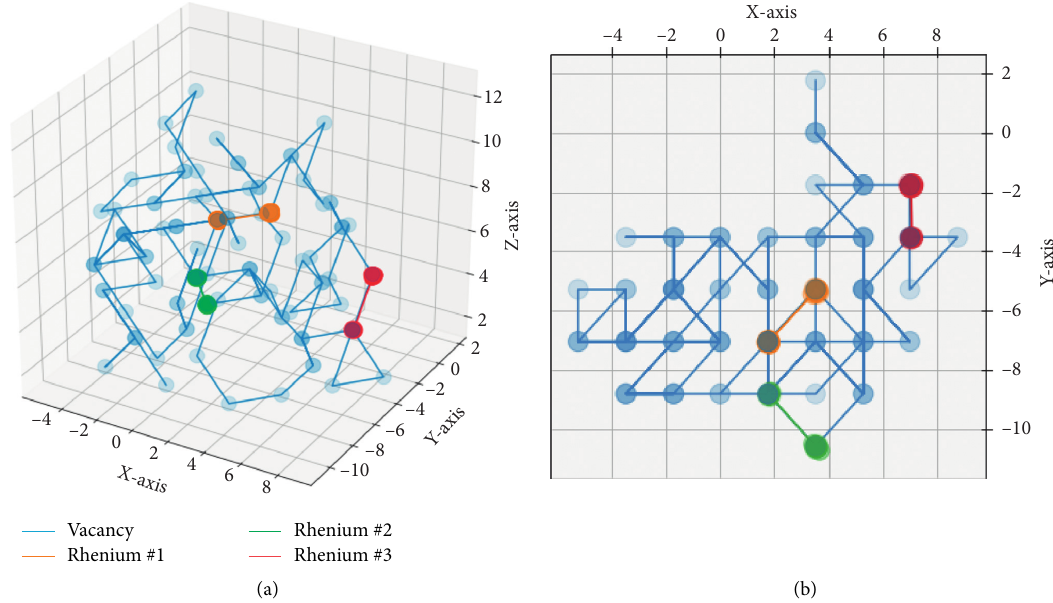
Figure 4: Atomic trajectories of vacancy (blue spheres) and Re (red, green, and orange spheres) in the simulation box are displayed. The coordinate system is Cartesian. (a) The trajectory in three-dimensional space and (b) the projection of the trajectory on the x - y